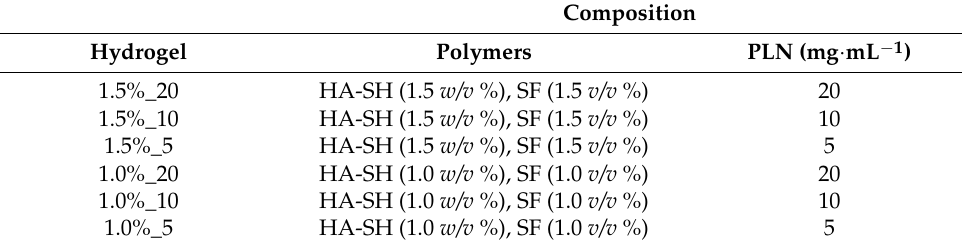
Table 1. Hydrogel formulations.